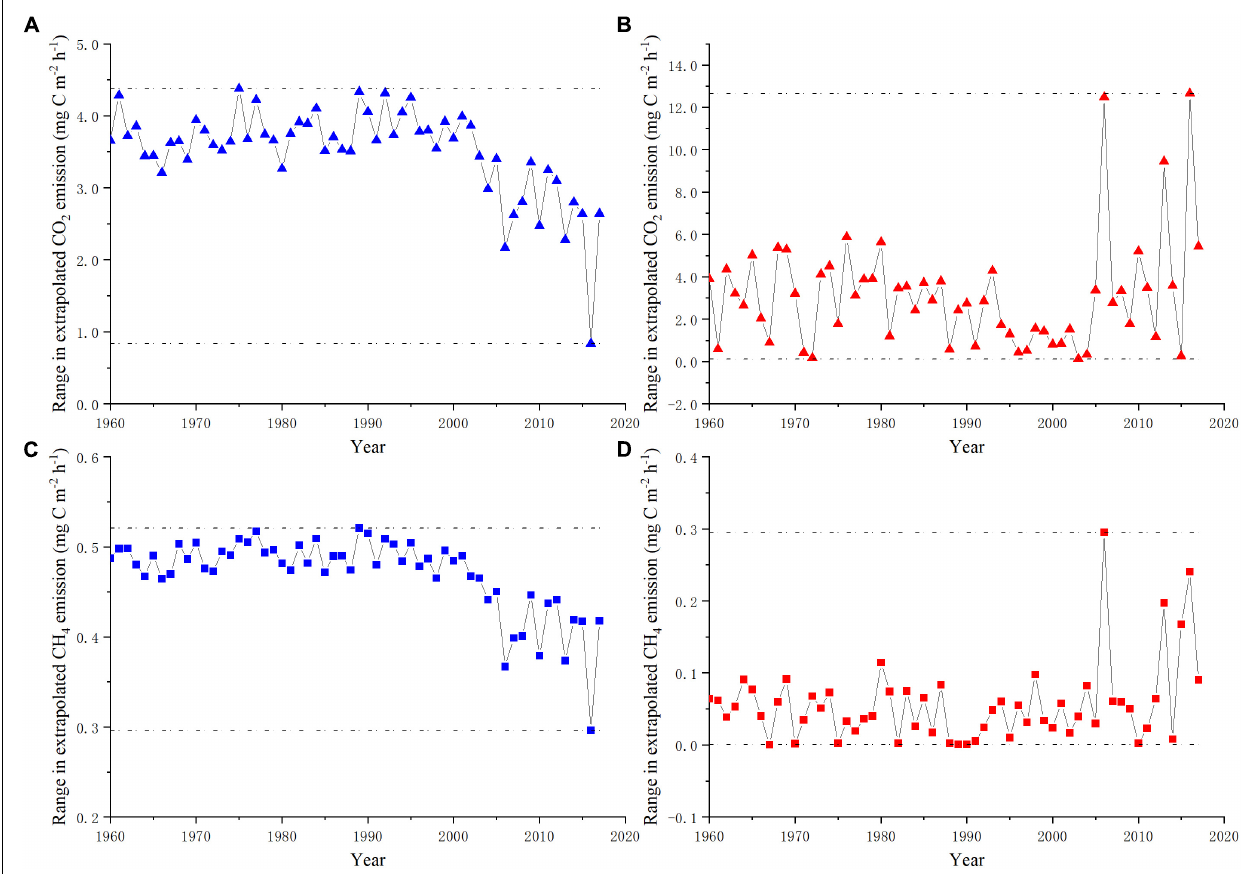
FIGURE 5 | Calculated differences between extrapolated annual greenhouse gas emission rate of study site from 1960 to 2017. CO 2 and CH 4 emission rates were extrapolated by models based on data derived from the static chamber method (A,C) or Eddy covariance method (B,D) at annual and NG&G seasonal timescales, respectively. The differences between the maximum and minimum extrapolated values of each year were